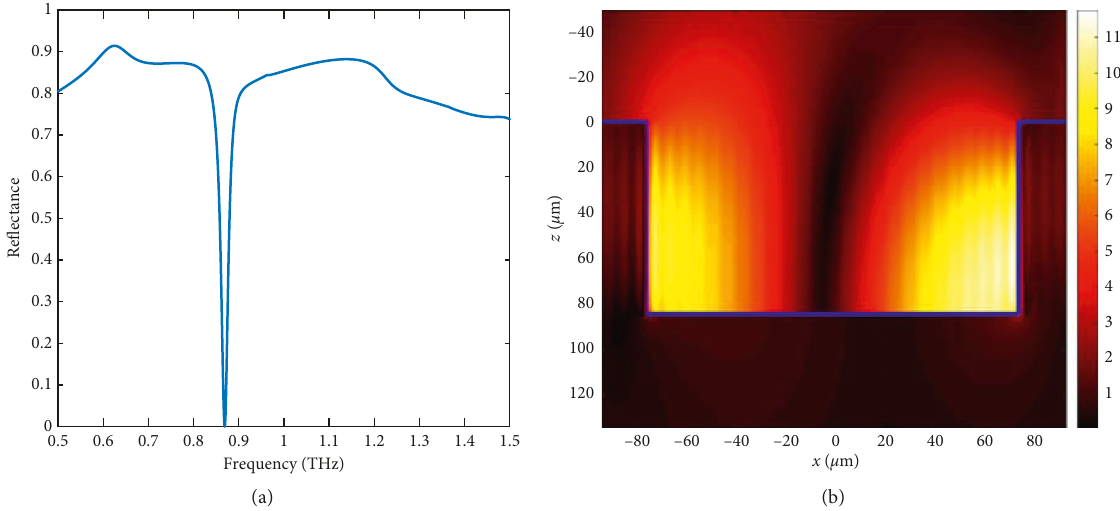
Figure 6: (a) Reflectance as a function of frequency and (b) | H